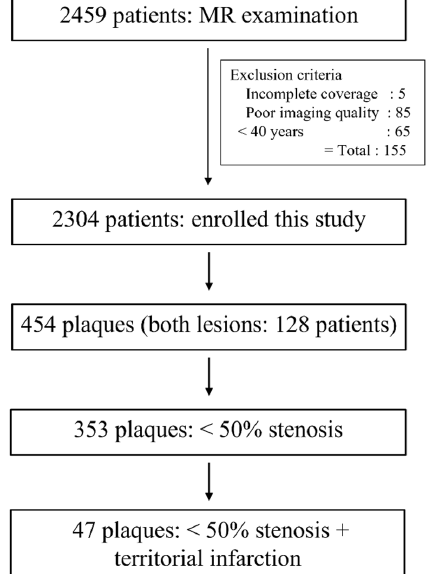
Figure 1. Flow diagram of patients.